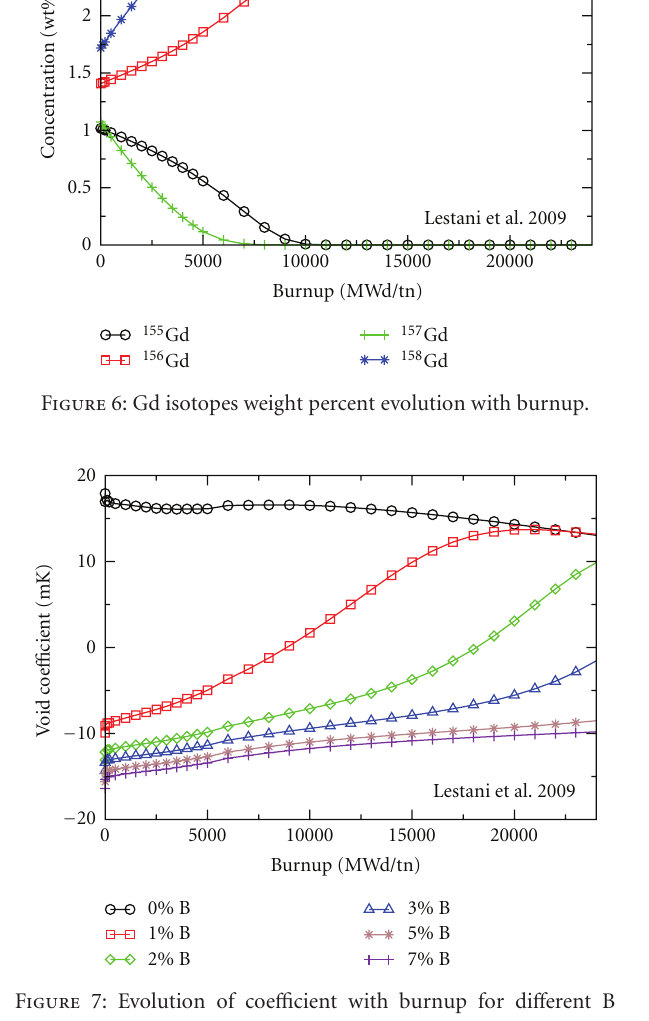
Figure 7: Evolution of coe ffi cient with burnup for di ff erent B